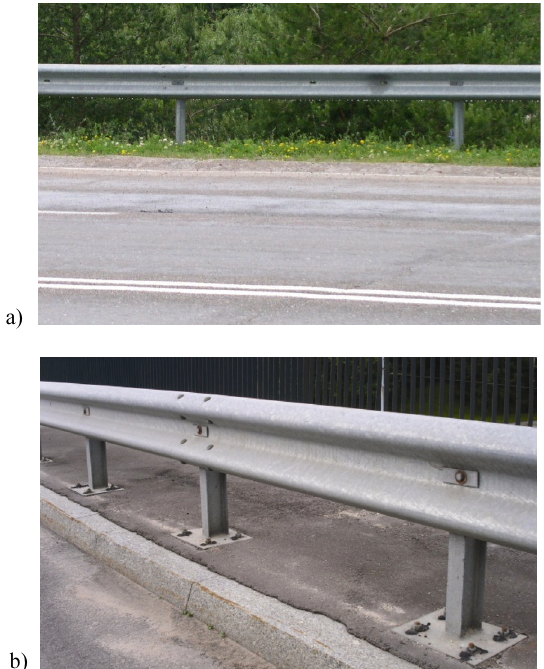
Fig. 5. The double-wave guardrails, most commonly used on Lithuanian and Ukrainian roads (our photos)